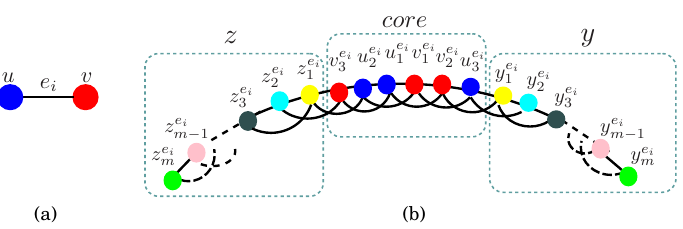
Fig. 5: (a) an edge e i ; (b) gadget corresponding to e i .